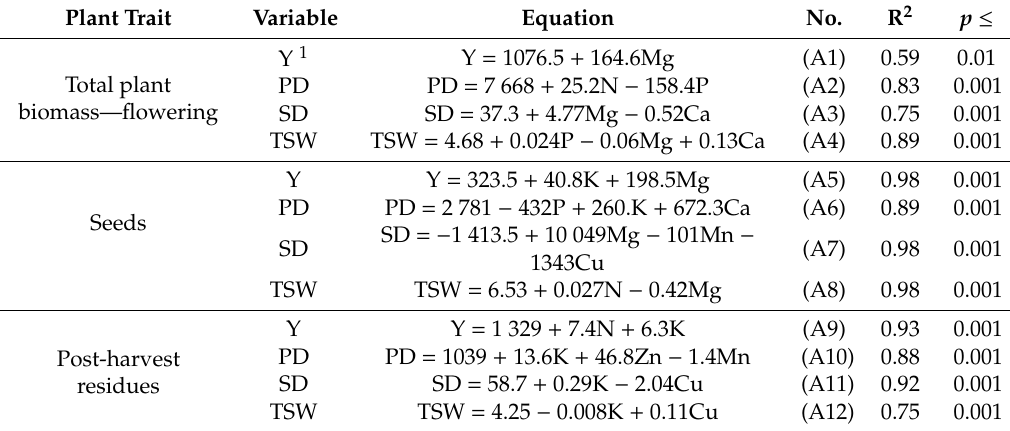
Table A4. Stepwise regression models of main variable response to the amount of nutrients accumulated in WOSR traits, n =